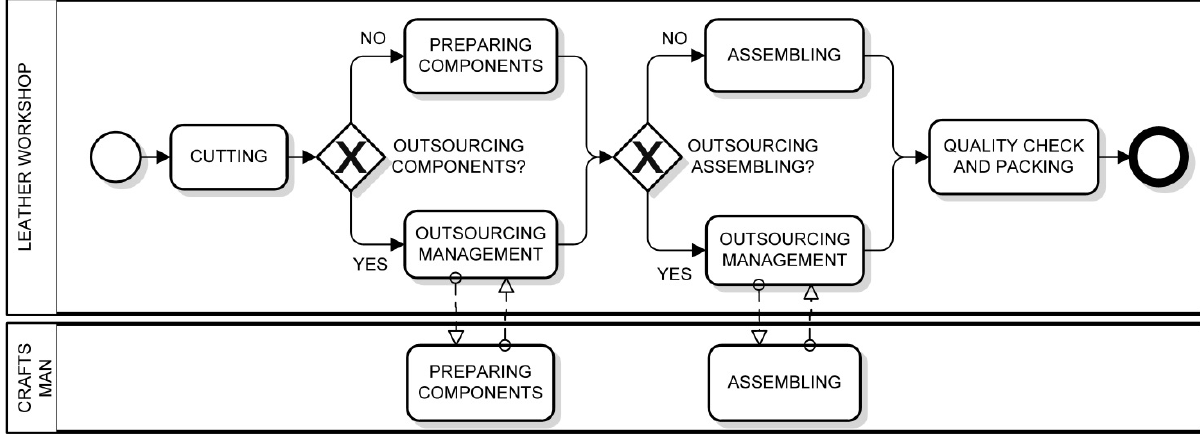
Figure 3. A BPMN process diagram representing the macro processes of bag manufacturing in a leather